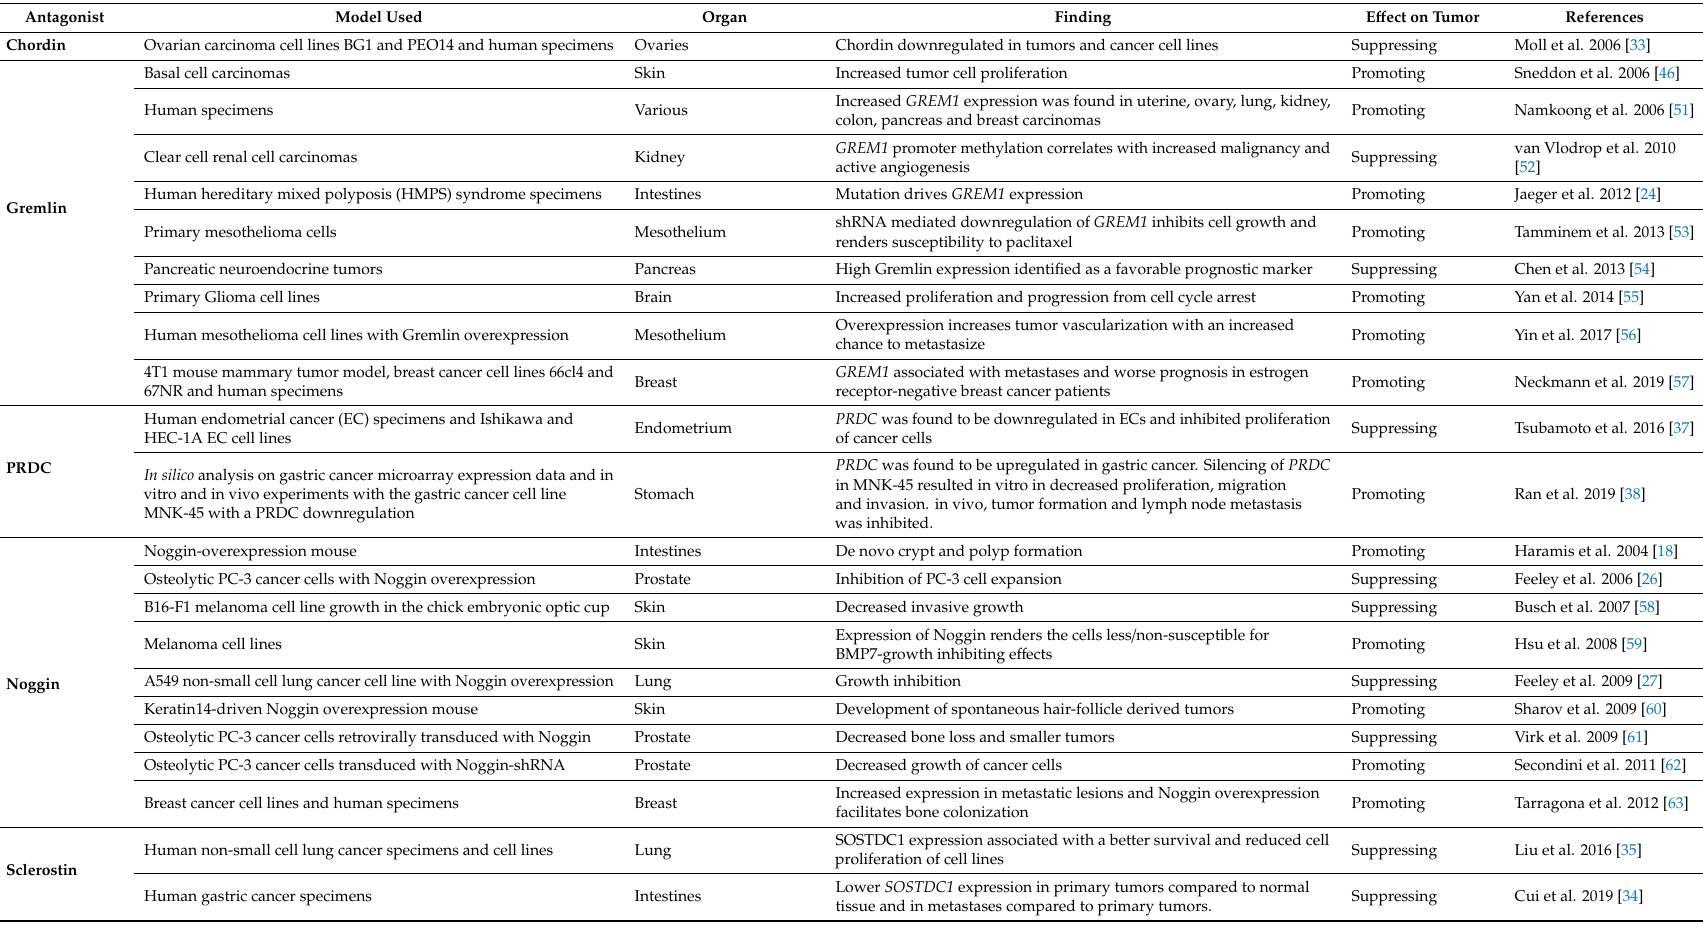
Table 1. Overview of studies concerning the role of BMP antagonists in